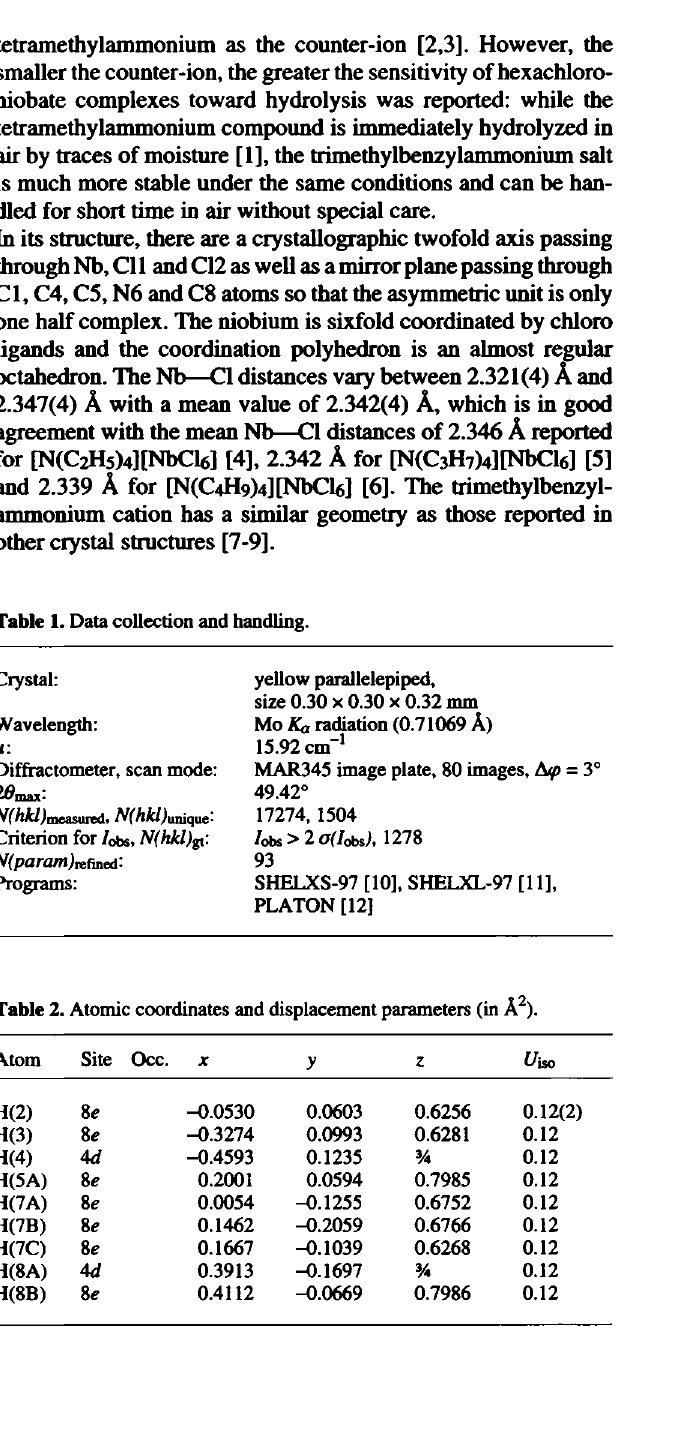
Table 2. Atomic coordinates and displacement parameters (in Â 2